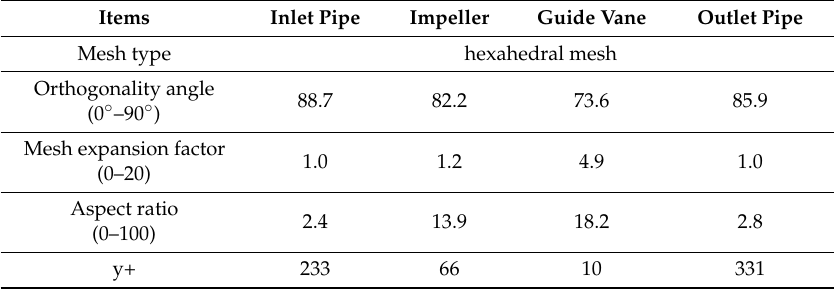
Table 4. Detailed mesh information for each part of Mesh